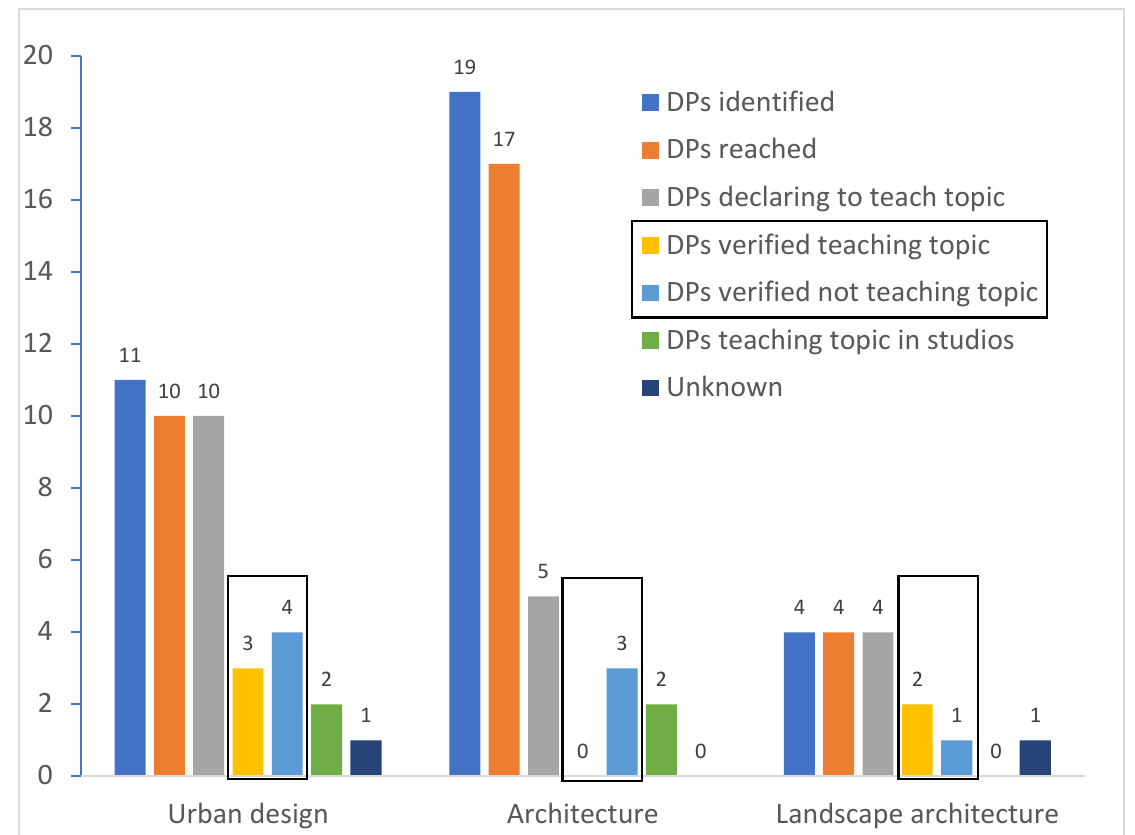
Figure 2. Summary of the results. A Master in Spatial Development and Landscape Architecture is listed twice—once in landscape architecture and once in urbanism, because of the two separate study tracks. Boxes indicate results after the verification of courses for actual topic content. Unknown indicates two courses that declared teaching the topic, but for which the actual course content could not be inspected.